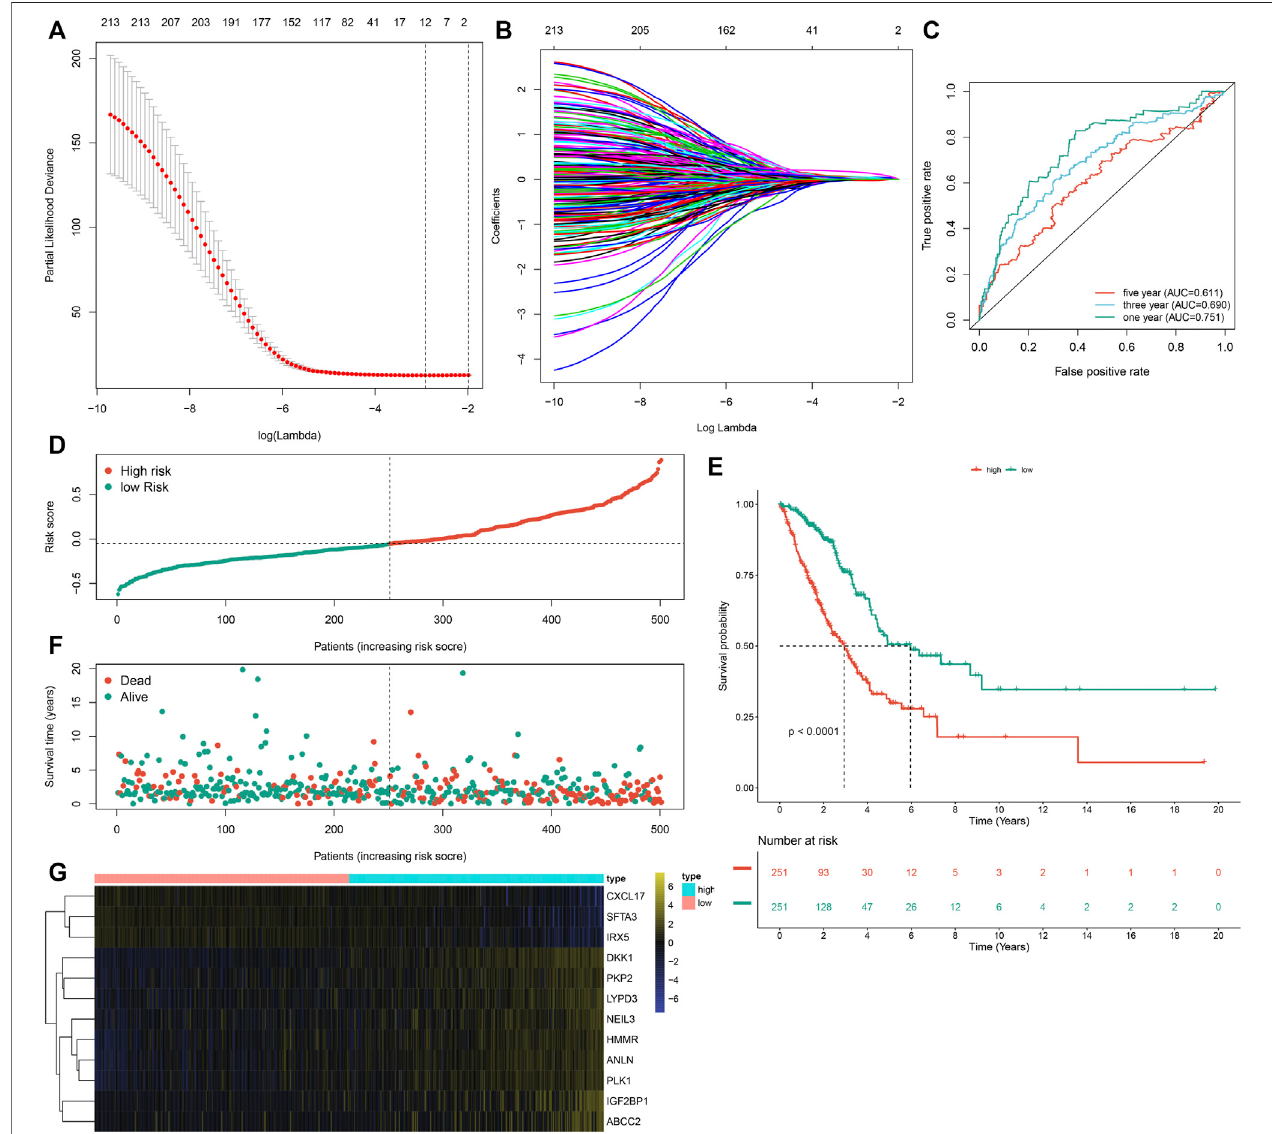
FIGURE5| Developmentofanm 6 AriskscoreforLUADbyLASSO-coxregressionanalysisinLUADsamplesfromtheTCGAcohort. (A) Partiallikelihooddeviance ineachlambdavaluefortheLASSO-coxregressionanalysis. (B) ProcessofvariableselectionintheLASSO-coxregressionmodelby10-foldcross-veri fi cation. (C) ROC curvesunderone,threeand5-yearOSbasedonthem 6 Ariskscore. (D) Thedistributionofthem 6 Ariskscoreandidenti fi cationofthemedianm 6 Ariskscoreindicatedby vertical dotted line. (E) Kapan-Meier curves of OS for high- and low-m 6 A risk score groups, followed by log-rank test. (F) The distribution of survival status in high- and low-m 6 A risk score groups. Red dots indicated dead status and blue dots indicated alive status. (G) Hierarchical clustering analysis for the mRNA expression patterns in LUAD samples from high- and low-m 6 A risk score